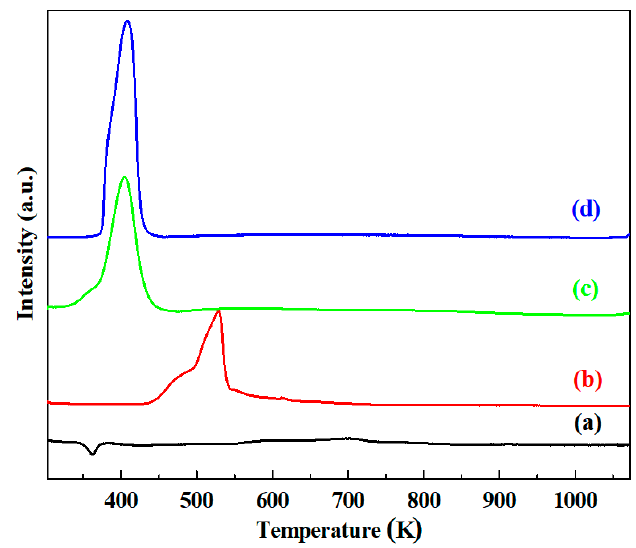
Figure 2. TPR profiles of catalysts: ( a ) PdO/ γ -Al 2 O 3 ; ( b ) CuO/ γ -Al 2 O 3 ; ( c ) CuO-PdO/ γ -Al 2 O 3 ; ( d ) CuO- PdO/(Mg) γ -Al 2 O 3. ( d ) CuO-PdO/(Mg) γ -Al 2 O 3.